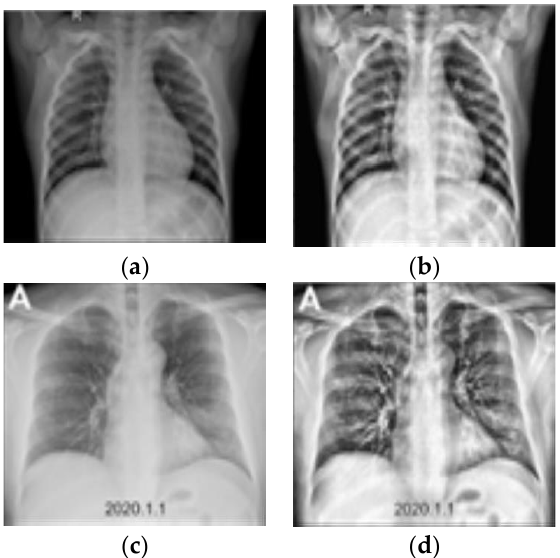
Figure 2. X-ray images: ( a ) non-COVID-19 (healthy) pre-CLAHE; ( b ) non-COVID-19 (healthy) post-CLAHE; ( c ) COVID-19 pre-CLAHE; and ( d ) COVID-19 post-CLAHE.